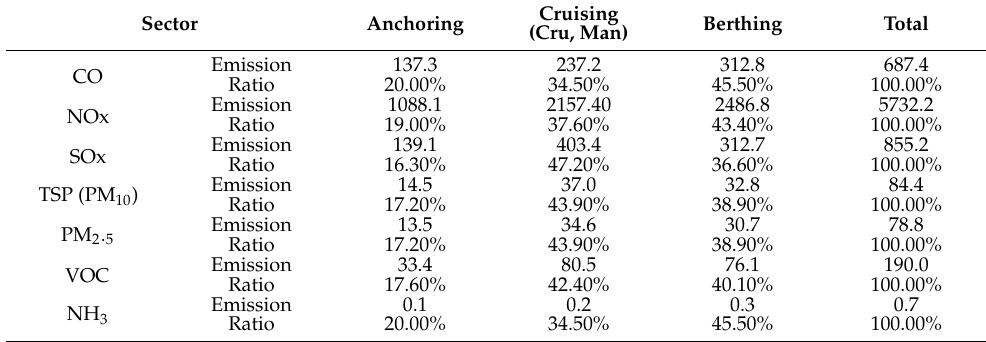
Table 6. Air pollutant emissions by activity phase.